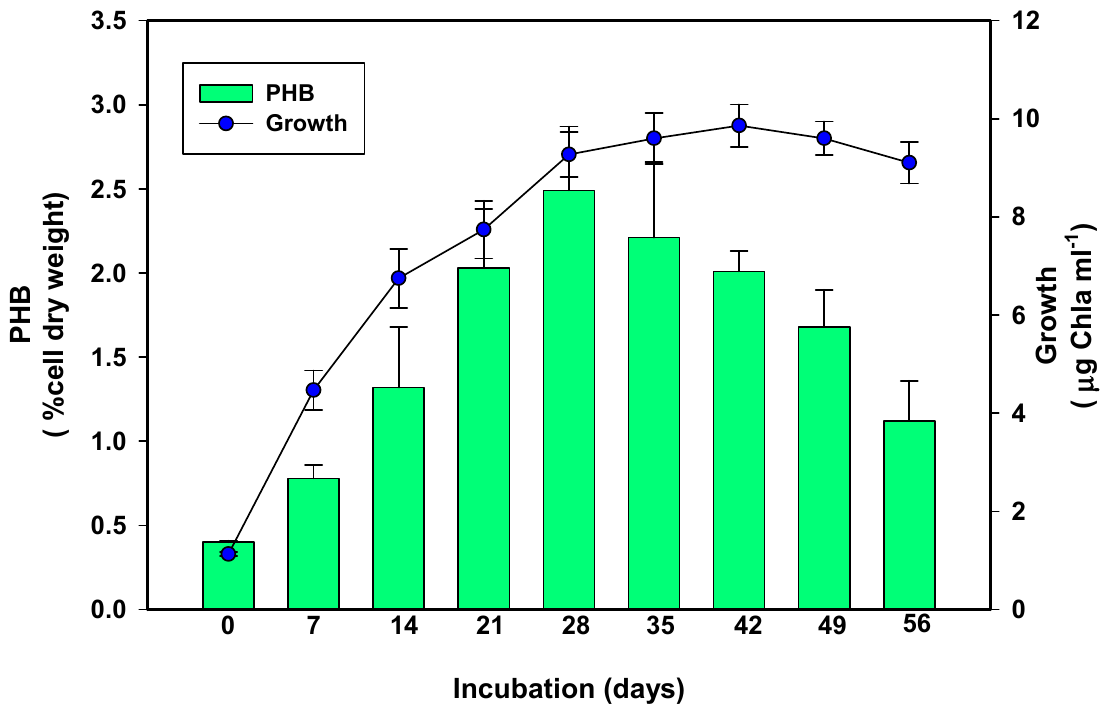
Figure 2. Production of PHB in S. geitleri in relation to growth and the incubation period. Values are the mean ( n = 3) ± standard deviation (SD).